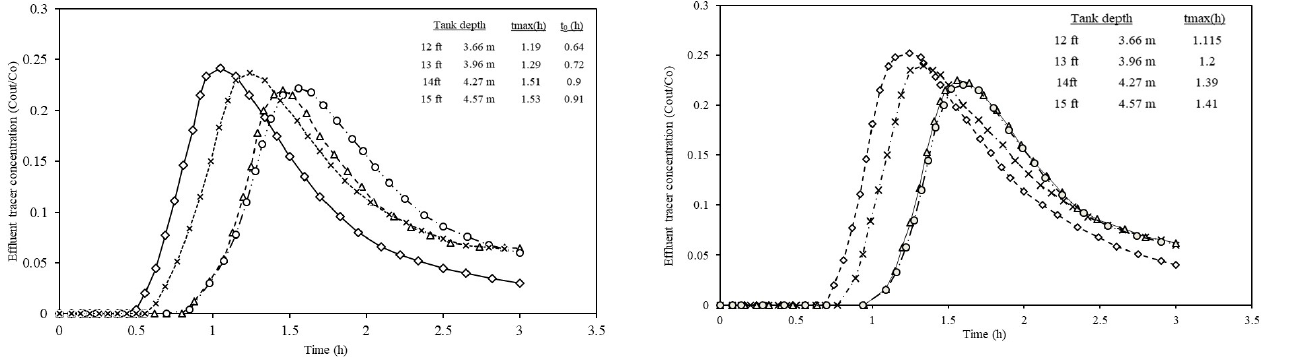
Figure 7. Effluent concentration and t max in tank depth variations and 42.67m diameter.